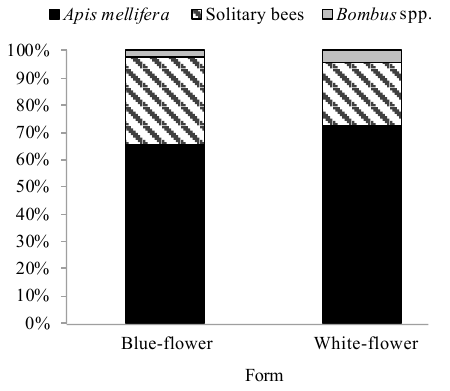
Fig. 3 Percentages of insect taxa visiting two forms of Polemonium caeruleum investigated in Lublin, SE Poland. Data from the period of 2012–2014 are